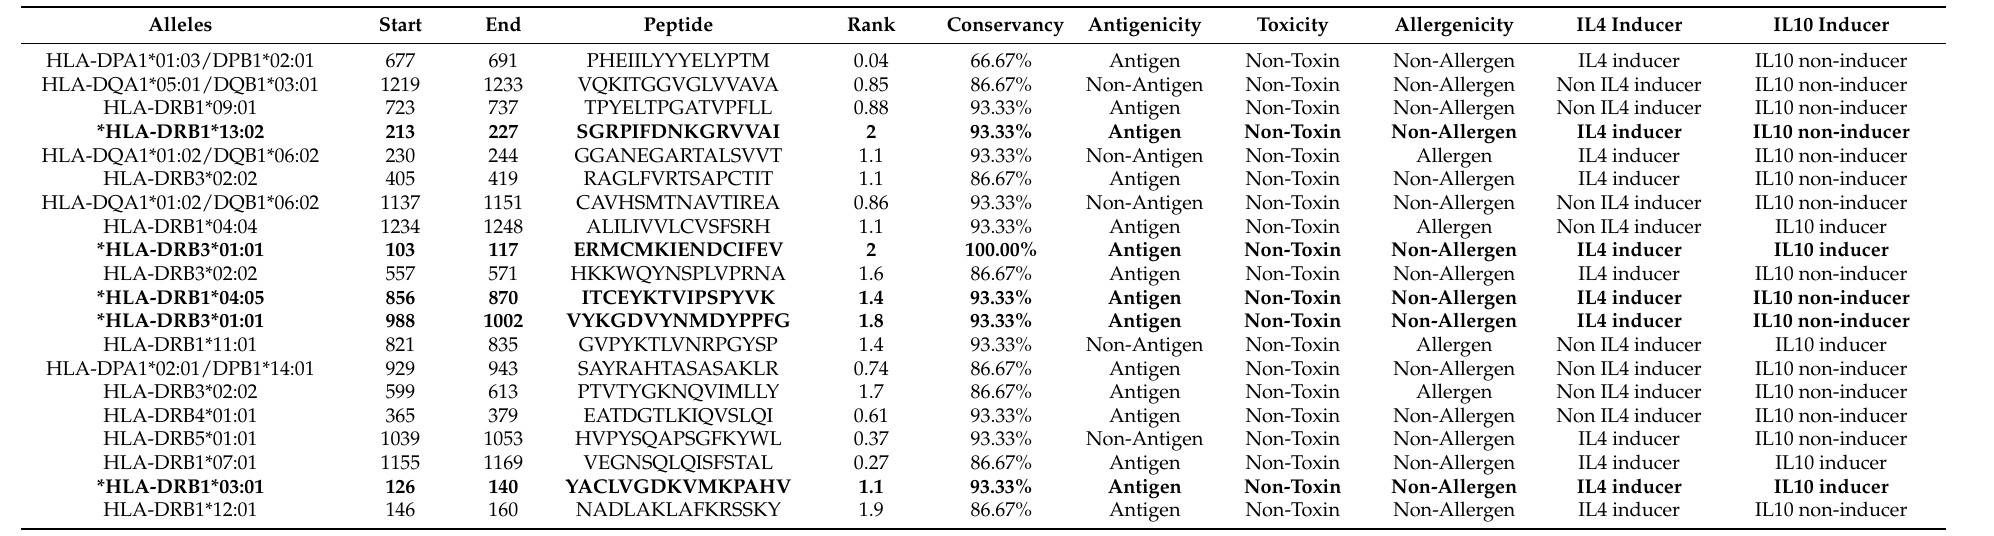
Table 2. MHC-II binding T-cell epitopes